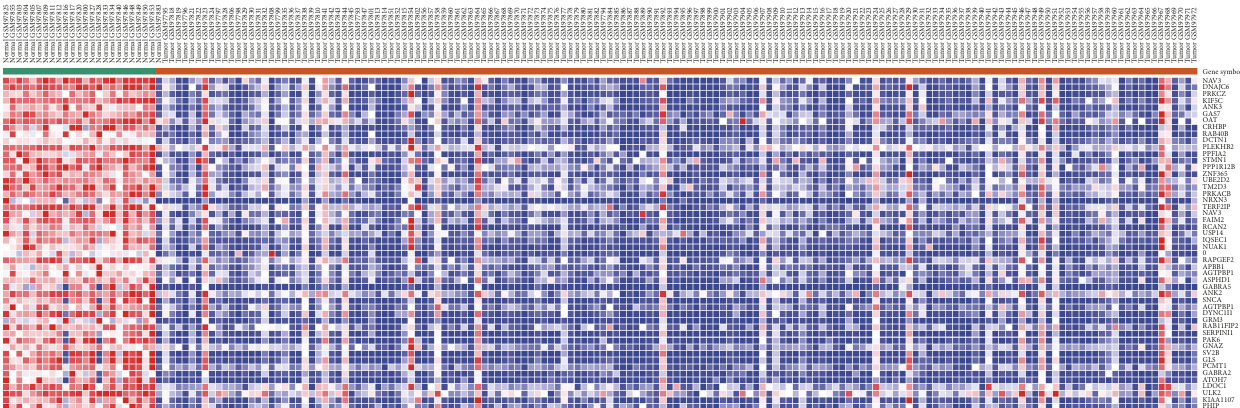
Figure 1: Heat map of the top 50 downregulated genes (red: upregulated; purple: downregulated). Table 1: Gene ontology analysis of downregulated genes associated with